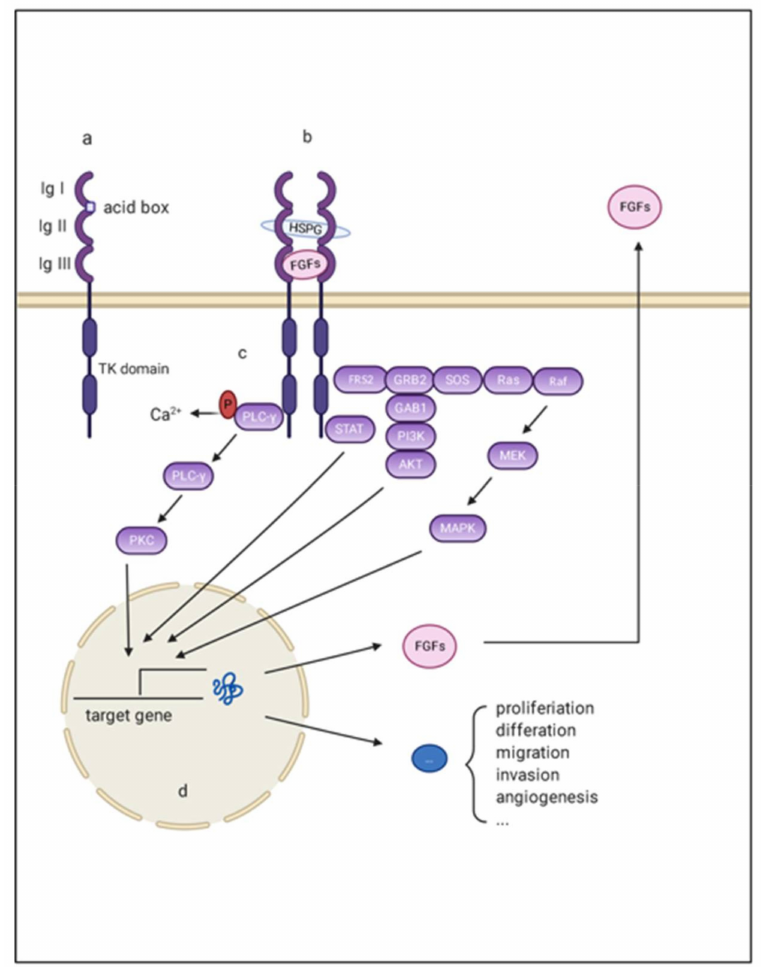
Figure 1. Schematic representation of aberrant FGF/FGFR signaling in HCC. ( a ) FGFR monomer structure: FGFRs are comprised of the extracellular domains linked to intracellular catalytic domains via a single pass transmembrane domain. The extra extracellular domains contains three loops (namely Ig I, Ig II, and Ig III), and an acid box with rich serine; ( b ) The complex composed of FGF, FGFR, and the co-factors: Ig I and the acid box is re-sponsible for signal autoinhibition, while Ig II and Ig III are essential for signal transmission through binding with FGF and the co-factors; ( c ) The intracellular downstream signaling of FGF/FGFR signaling: There are mainly four pathways acting as canonical downstream signaling pathways of FGF-FGFR signal: mitogen-activated protein kinase (MAPK); phosphatidylinositol 3-kinase (PI3-kinase), phospholipase C γ (PLC γ ), and signal transducer and activator of transcription (STAT); ( d ) The target effects of FGF/FGFR signaling: